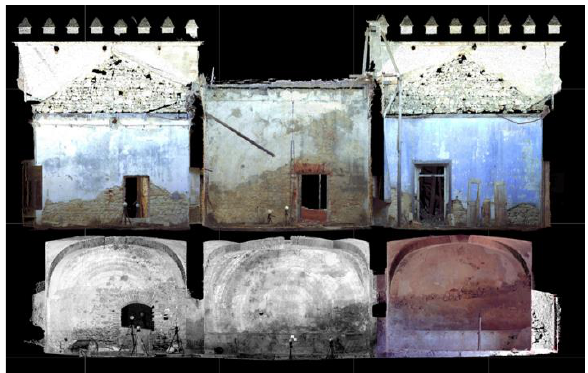
Figure 10. Ortho-image from laser scanning data from which drawings can be obtained.